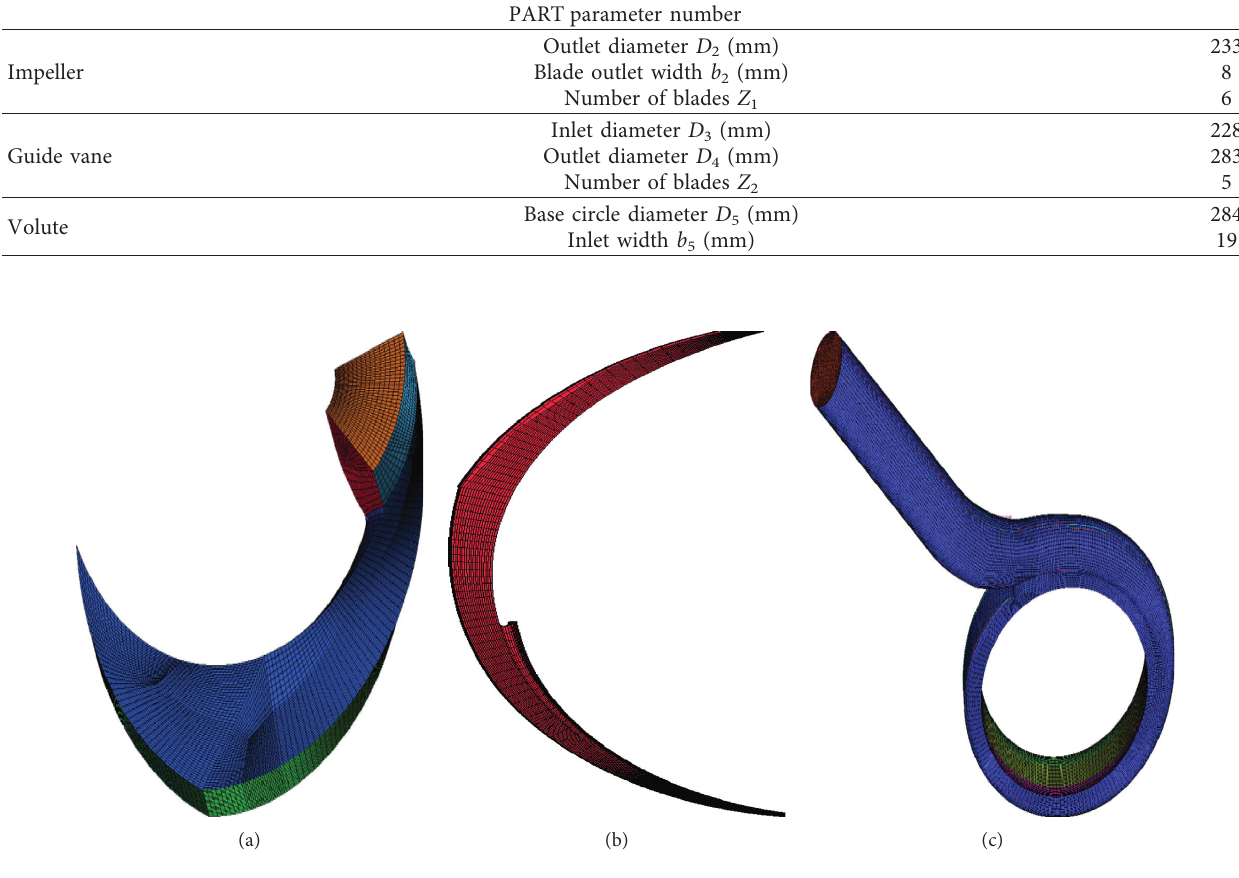
Figure 2: Three-dimensional meshing with grid: (a) impeller; (b) guide vane; (c)